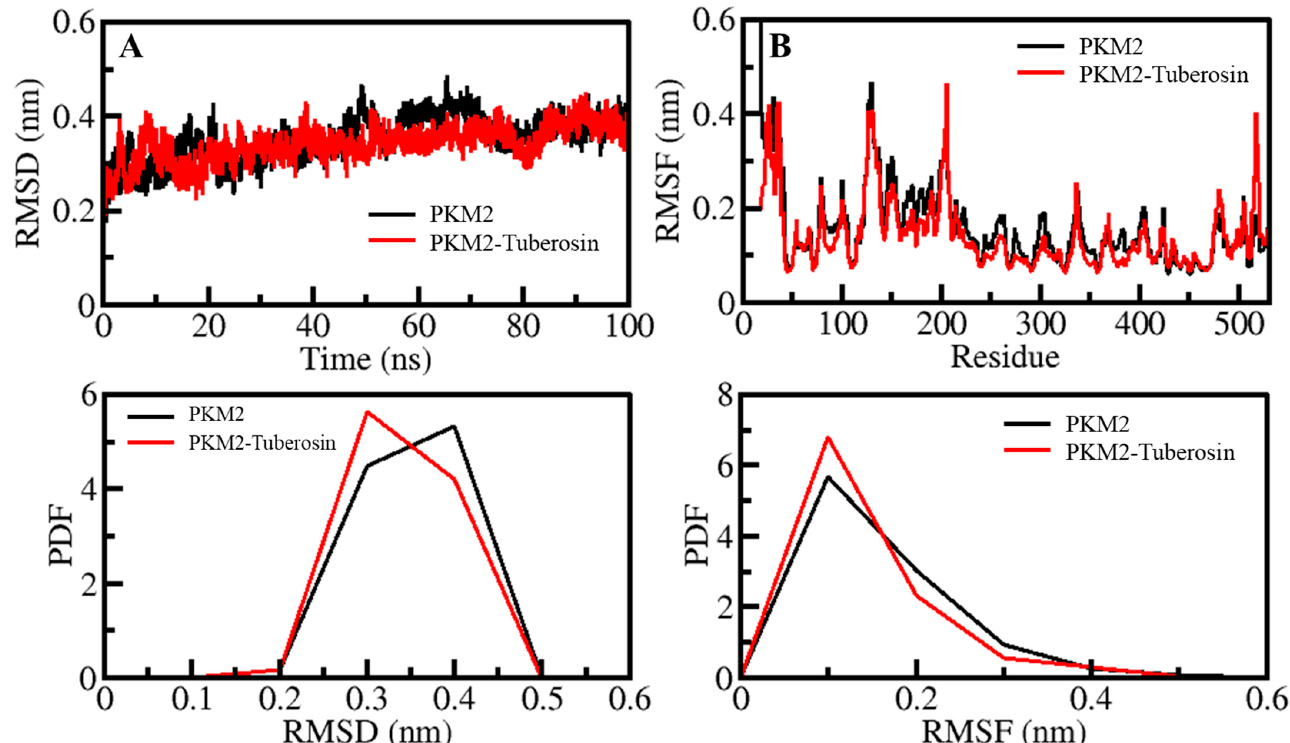
Figure 2. Dynamics of PKM2 and its binding with Tuberosin. ( A ) RMSD plot of PKM2 before and after Tuberosin binding. ( B ) RMSF plot of PKM2 and its complex with Tuberosin. Lower panels show the distribution of parameters as